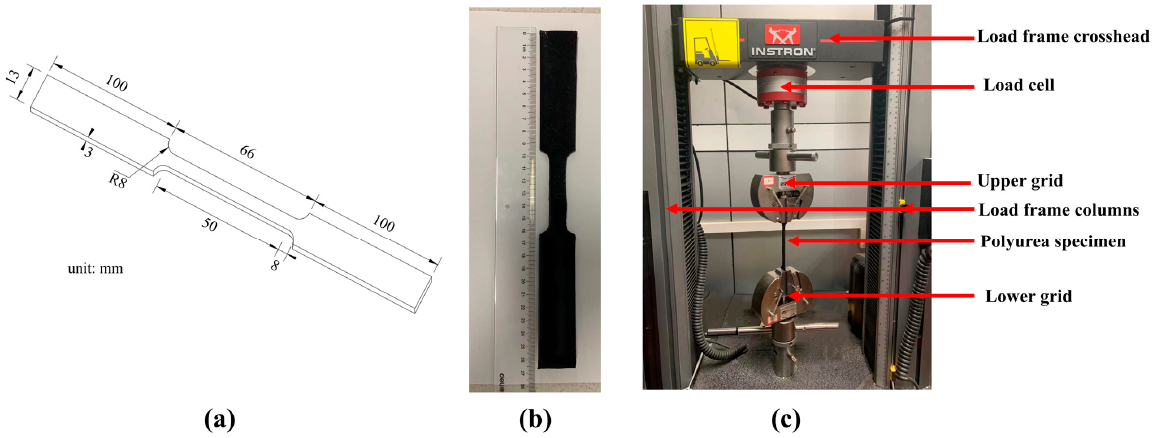
Figure 2. ( a ) tensile specimen outlines sizes; ( b ) appearance of polyurea specimen; and ( c ) the Instron tensile testing system.